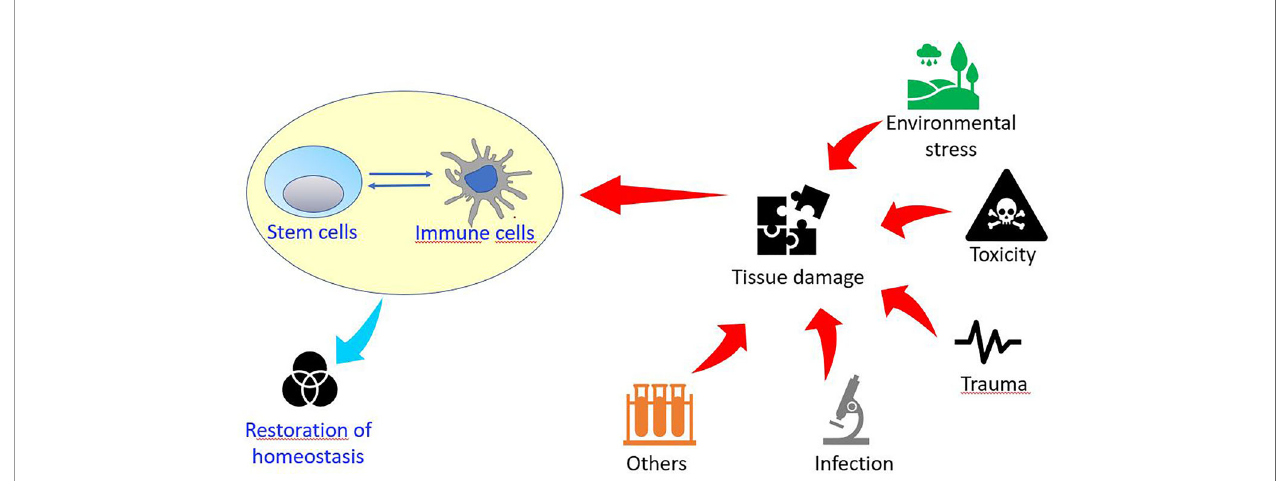
FIGURE 1 | Schematic drawing of the relationships between stem and immune cells and their involvement in stress